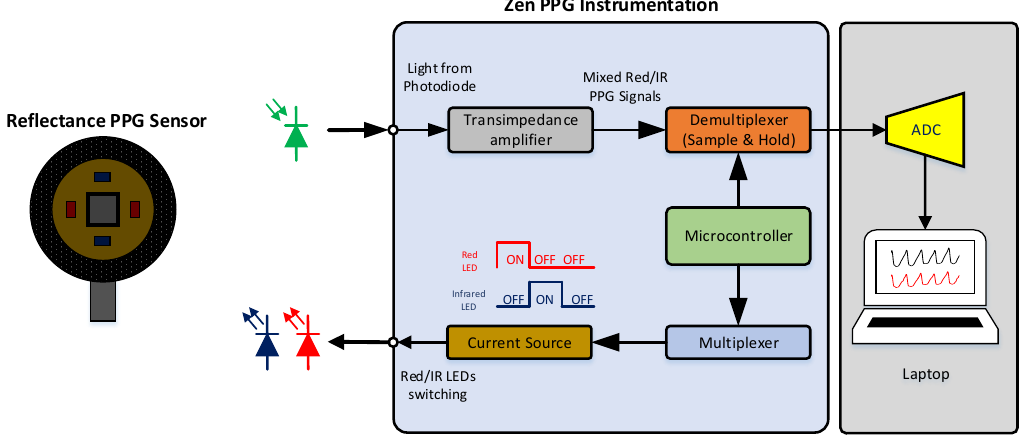
Figure 1. Block diagram representing the reflectance PPG sensor and the ZenPPG instrumentation. Light emitting diodes in the sensor are switched ON/OFF by the multiplexer and current source. The current produced by the photodiode are converted into voltages by the transimpedance amplifier and time-demultiplexed. An external ADC digitises the analogue signals from the instrumentation before acquisition of by a personal laptop/computer in